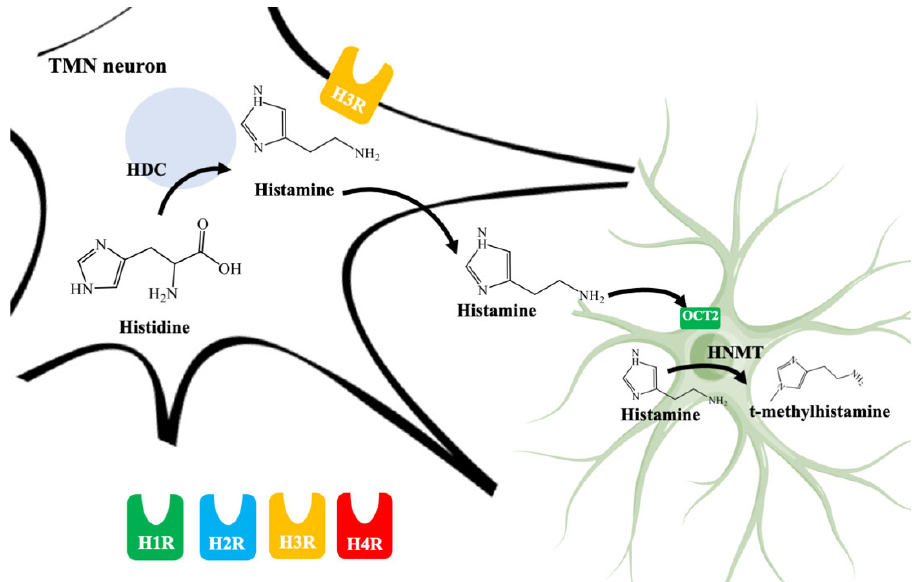
Figure 3. Schematic illustration of histamine synthesis, degradation, and types of histamine receptors. Histamine is synthesized by histidine decarboxylase (HDC) in neurons from the tuberomammillary nucleus (TMN). Histamine could interact with histamine receptors 1 to 4 (H1R, H2R, H3R, and H4R). Importantly, H3R are located presynaptically and regulates histamine release. The effect of histamine is ended by recapture in astrocytes mainly by organic cation transporter 2 (OCT2) and subsequent degradation by histamine N ‐ methyltransferase (HNMT) which is located in the cytosol. It has been shown that histamine, as with other monoamines, is transported from the cytoplasm of presynaptic nerves, through an electrochemical proton gradient generated by vacuolar H + adenosine triphosphatase, to secretory vesicles in neurons by the vesicular monoamine transporter 2 (VMAT-2) [78]. Histamine is released in the soma and